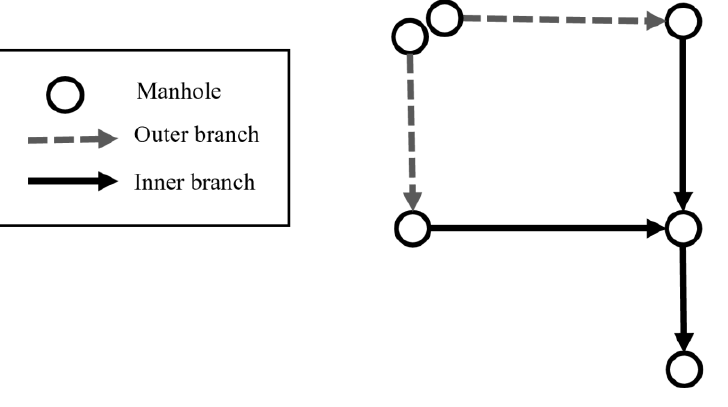
Figure 1. Types of pipes in the sewer network.